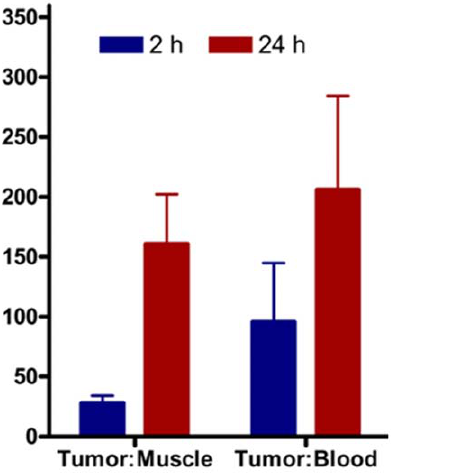
Figure 5. Graph representing tumor to muscle and blood respectively at early and late time-points. The Tumor/Muscle and Tumor/Blood ratios at 2 h and 24 h respectively calculated from the MIP images (SUVs). The ratios were higher at 24 h indicating improved contrast after clearance of the radioactive probe from the background tissues over time.